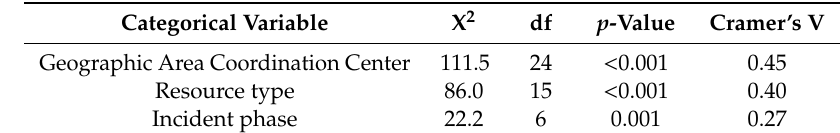
Table 5. Additional non-environmental categorical variables associated with US wildland firefighter entrapments (1981–2017). The results from a likelihood ratio test for independence between cluster type and each categorical variable are shown with the associated chi-square statistic (X 2 ), degrees of freedom (df), and the strength of the association based on Cramer’s V [47].